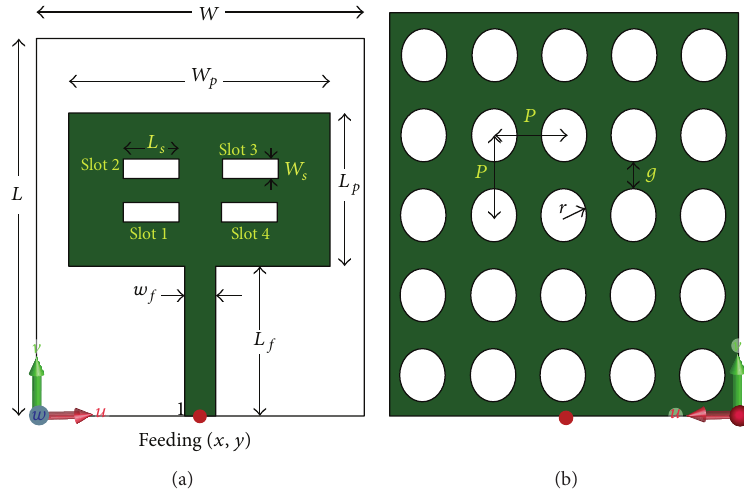
Figure 1: Geometry of the proposed multiband resonator, (a) front and (b) back view.